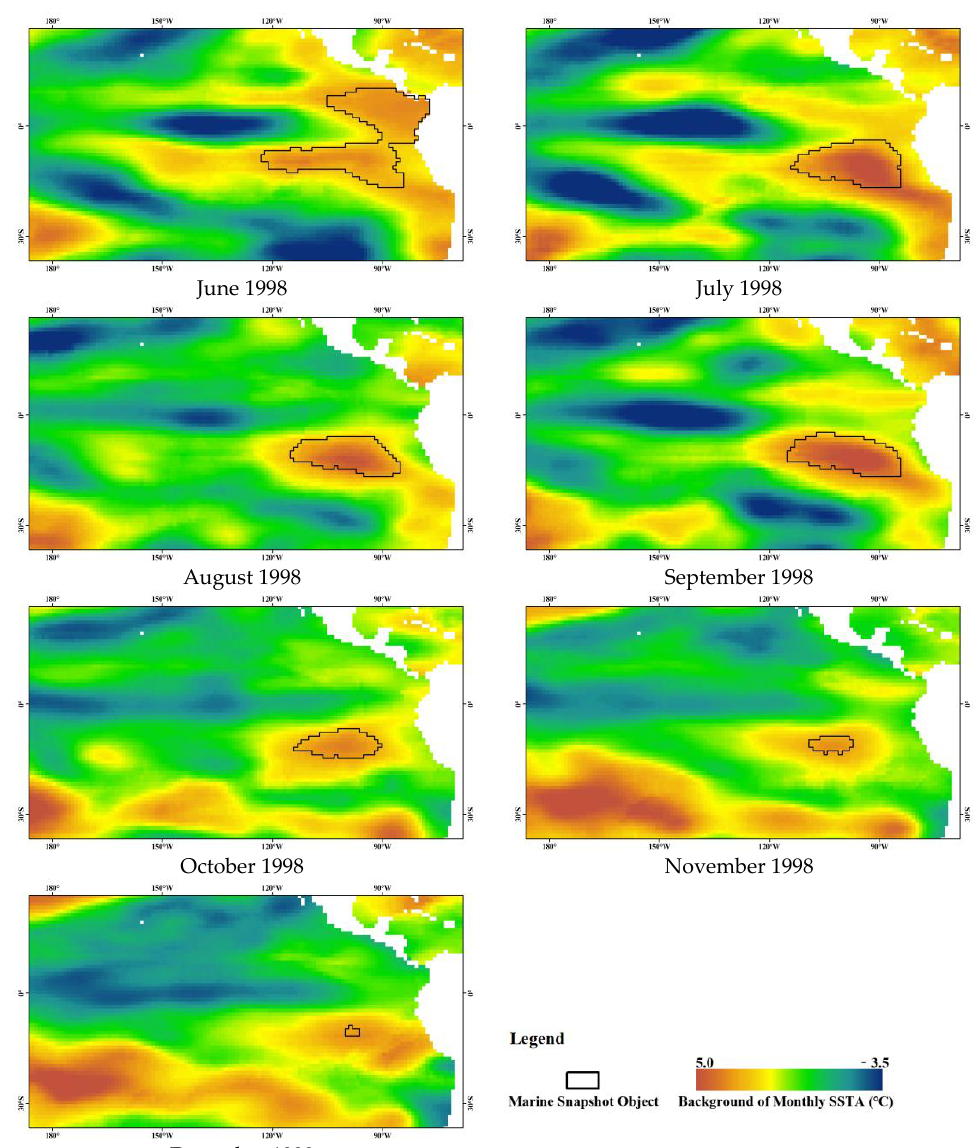
Figure 12. Sequence object 5 continues to decrease in the Equatorial Eastern Pacific Ocean from June to December 1998. The background is the monthly